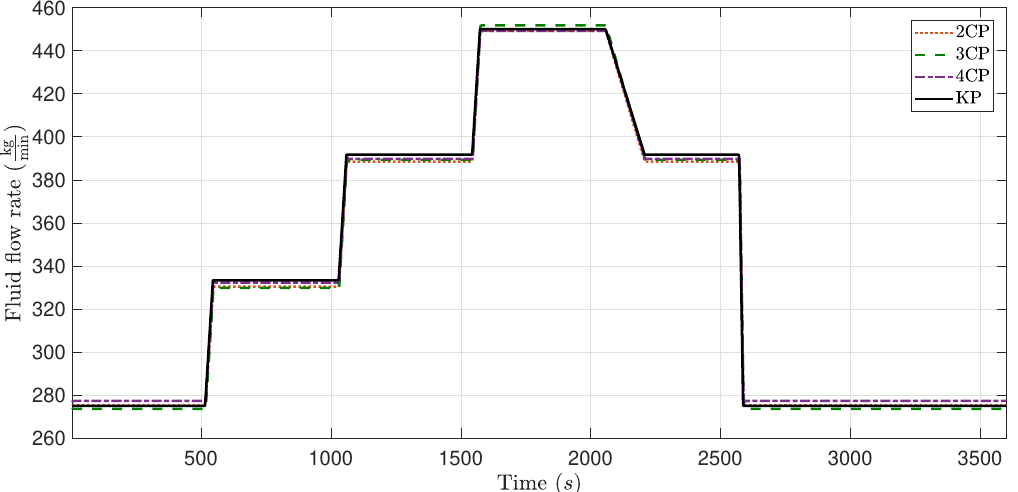
Figure 4: The mass flow rates calculated from different models for super–critical upstream conditions. ‘KP’: KP scheme and ‘2, 3 or 4 CP’: model with 2, 3 or